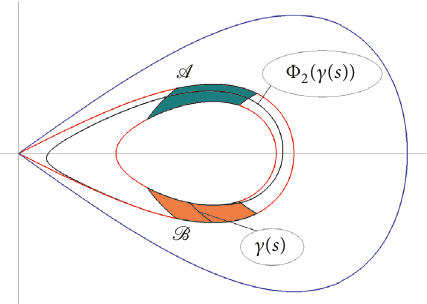
Figure 5: The present figure describes how a path 𝛾(𝑠) crossing B from B − 𝑙 to B − 𝑟 is stretched by Φ 2 to a path Φ 2 (𝛾(𝑠)) which crosses (once) A from A − 𝑙 to A − 𝑟 . As in Figure 2 we have considered 𝑓(𝑥) = = 2 , 𝑉 = 1. For this example we have taken 𝑇 𝑥 3 and 𝑉 1 2